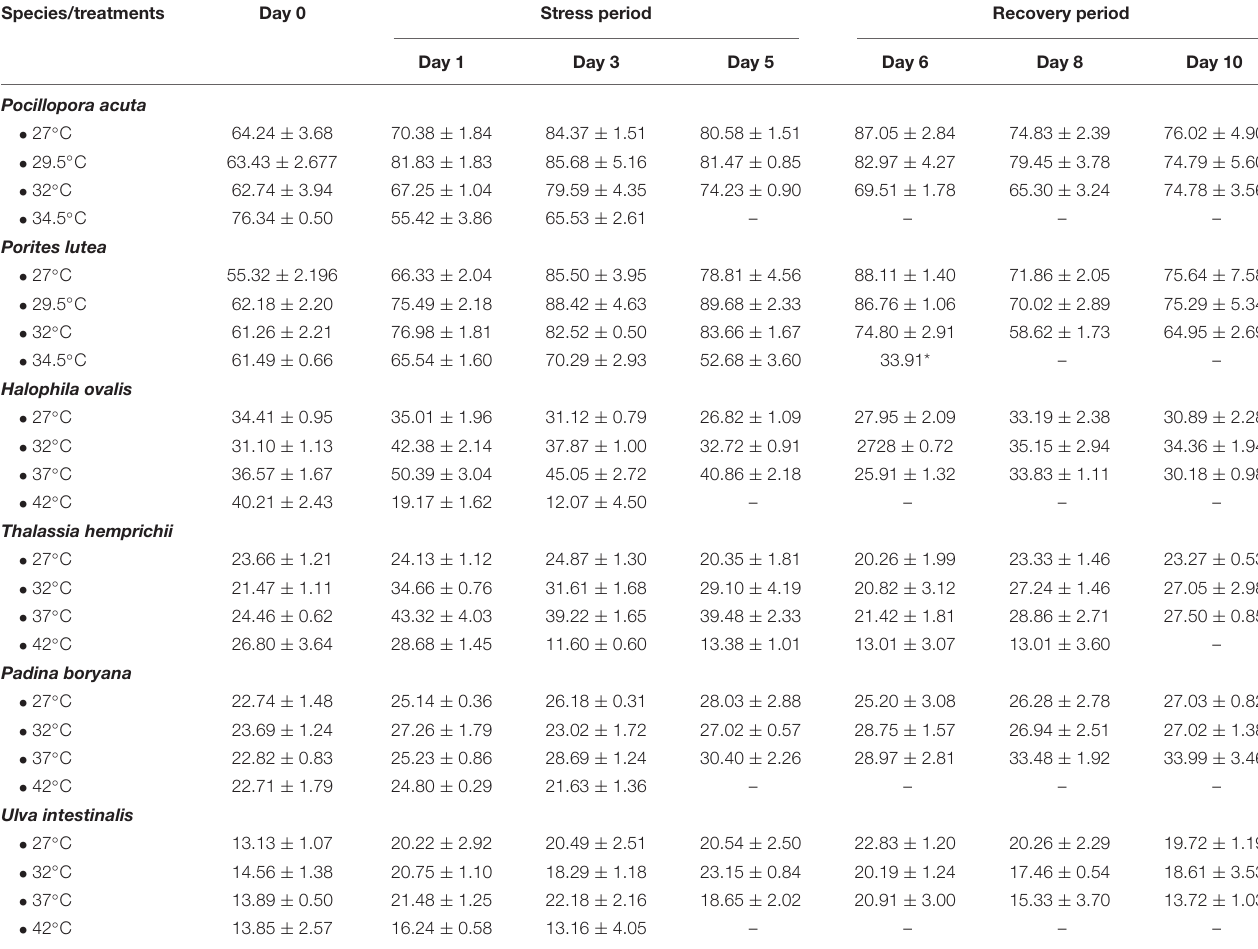
TABLE 1 | The maximum electron transport rates ( µ mol m − 2 s − 1 , ETR max ) derived from the rapid light curves (mean ± SE, n = 3). Species/treatments Day 0 Stress